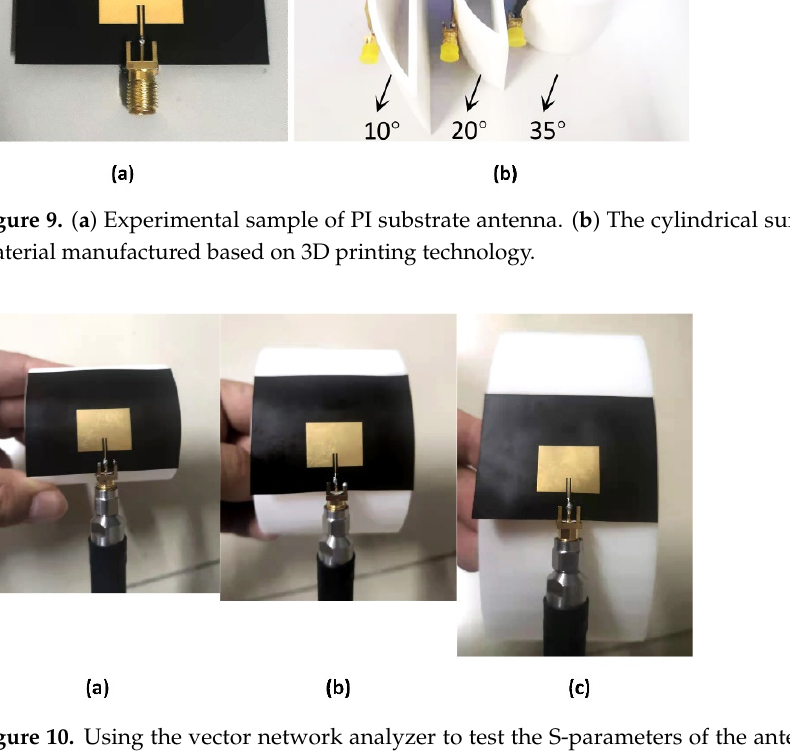
Figure 10. Using the vector network analyzer to test the S-parameters of the antenna experiment sample: ( a ) 35°, ( b ) 20°, and ( c ) 10°.